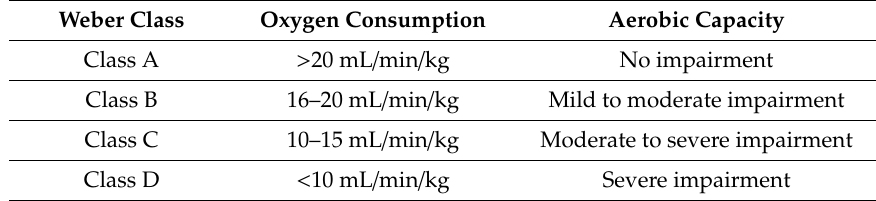
Table 1. Weber disability metric (30)